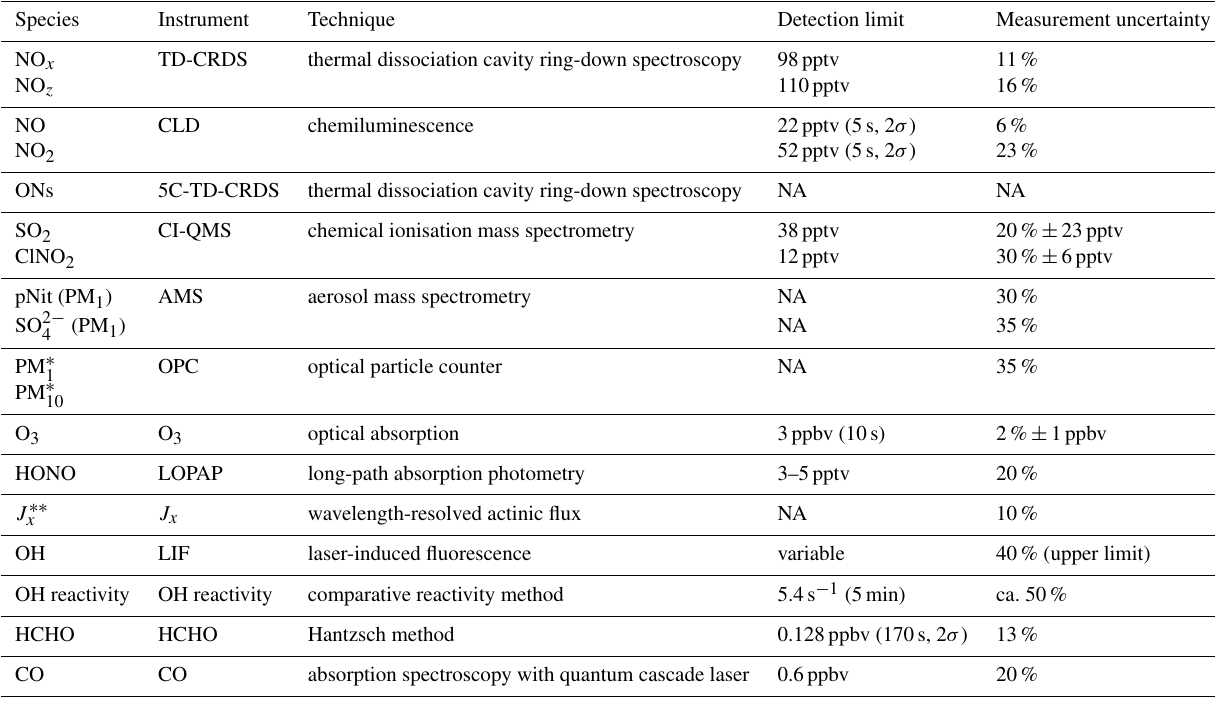
Table 1. Data sets used in the analysis and corresponding measurement characteristics.